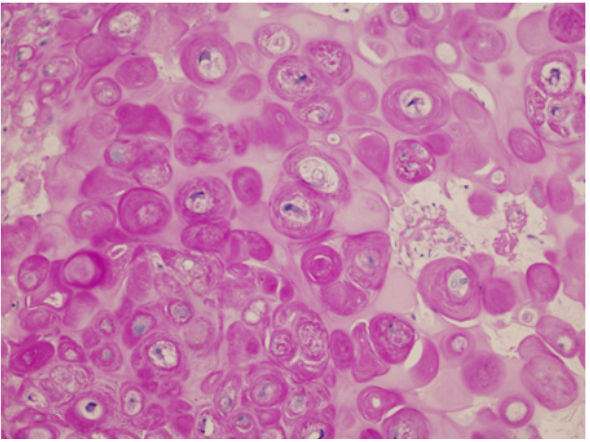
Fig. 6. Detail of target- like chondrocytes with thick APAS posi- tive rings that form the majority of cell population in soft tissue chondrosarcoma from previous picture. APAS, x100.